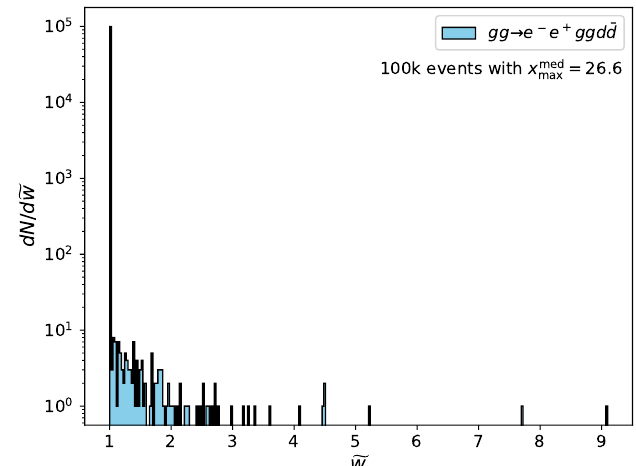
w of 100k g g → e − e + g gd ¯ d events in proton–proton Figure 4: Final event weights (cid:112) (cid:101) s = 13TeV generated using surrogate unweighting with x med collisions at